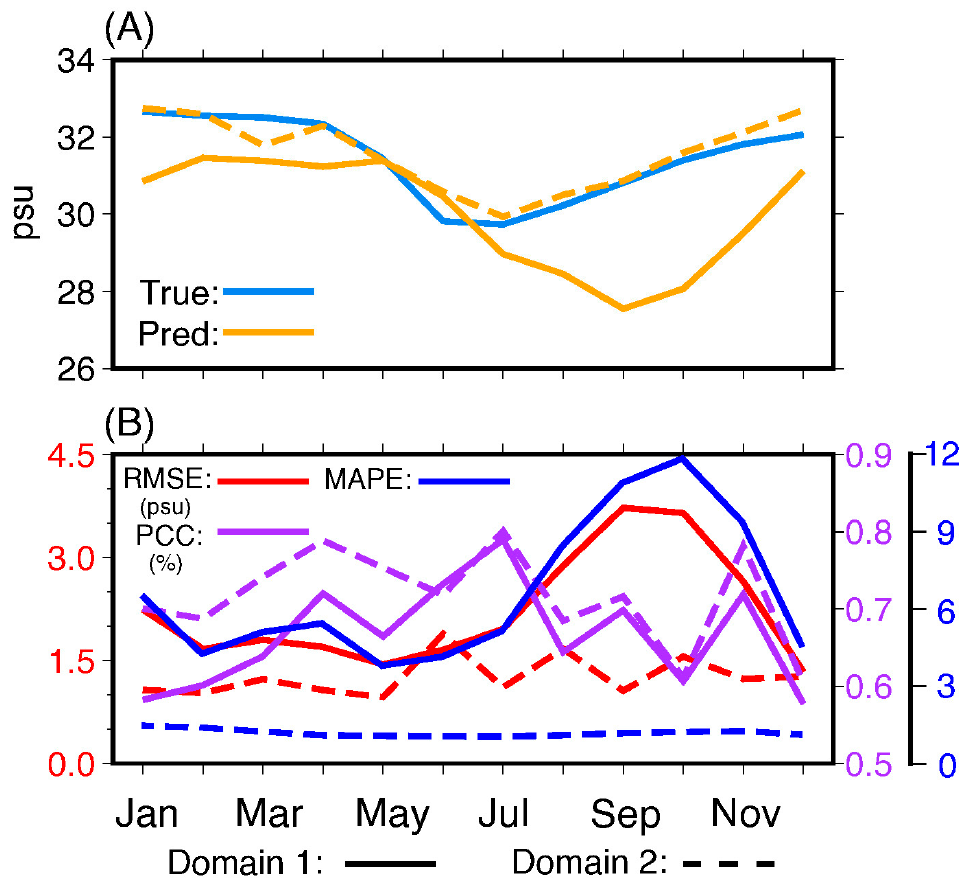
Figure 5. Temporal variations in true and predicted SSSs ( A ) together with the error estimations ( B ) over the CDWC region.